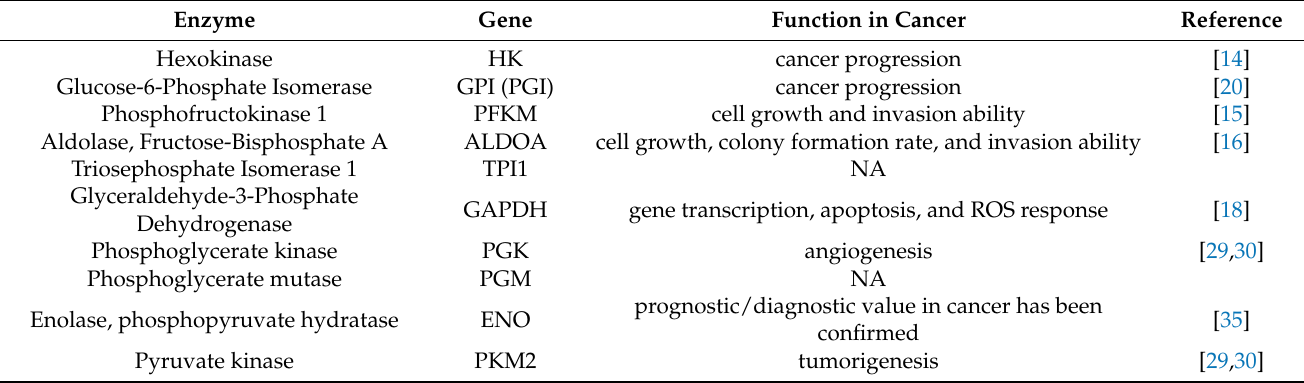
Table 1. Enzymes of glycolysis